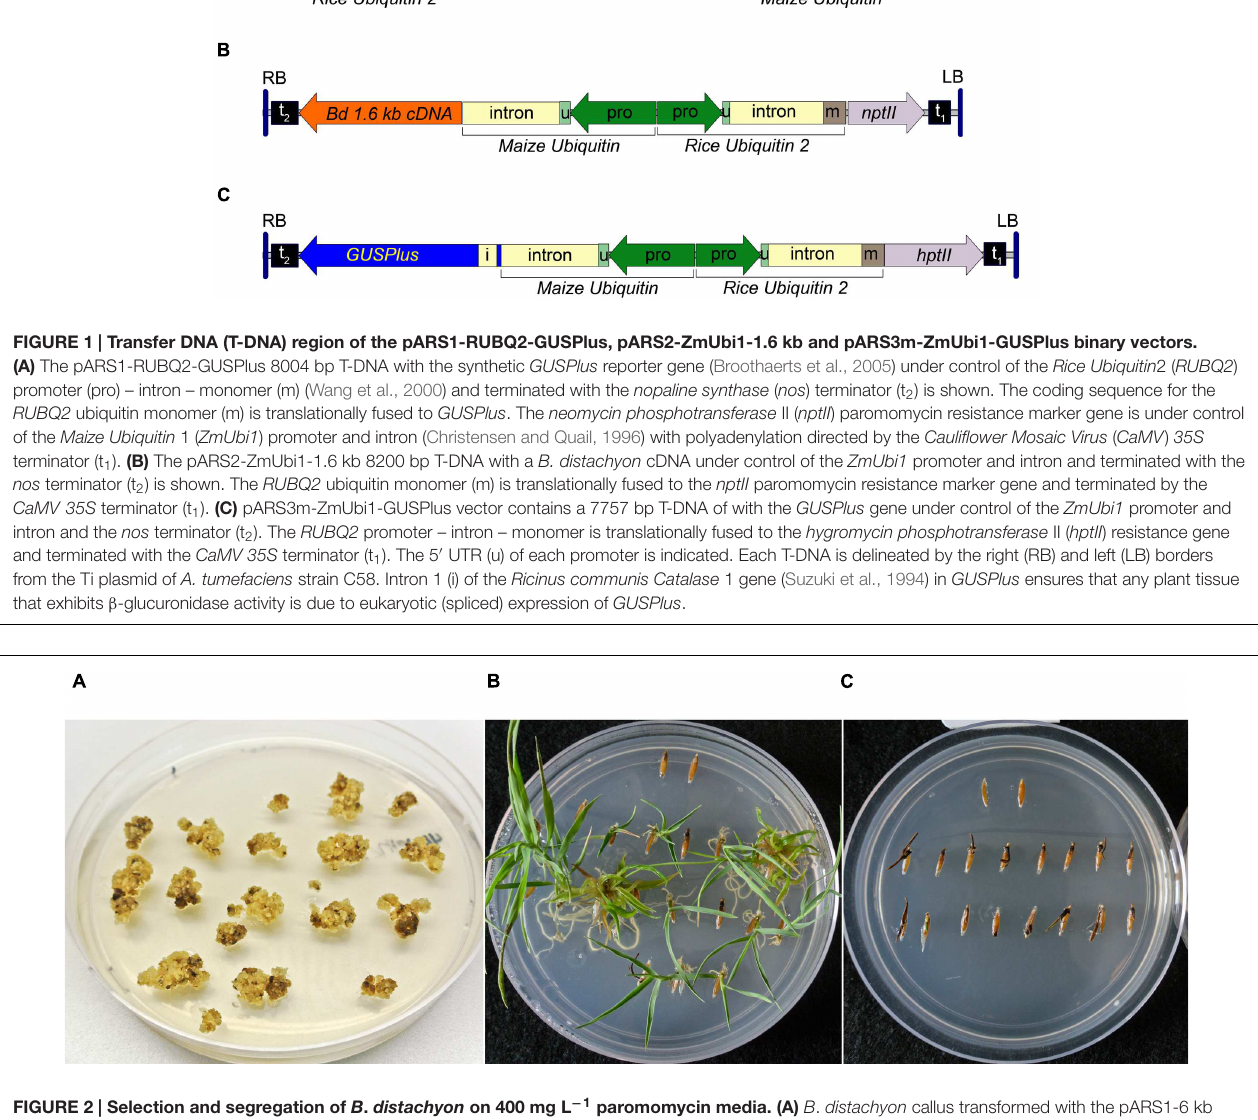
FIGURE 2 | Selection and segregation of B . distachyon on 400 mg L − 1 paromomycin media. (A) B . distachyon callus transformed with the pARS1-6 kb vector after 2 weeks under paromomycin selection. (B) Segregating transgenic T 1 family with individuals exhibiting robust paromomycin resistance. (C) Non-transgenic line (escape) which is susceptible to paromomycin selection. For comparison purposes two wildtype (WT) seeds were included in the upper region of each germination plate. Plates were photographed 37 days after the seed was placed on the